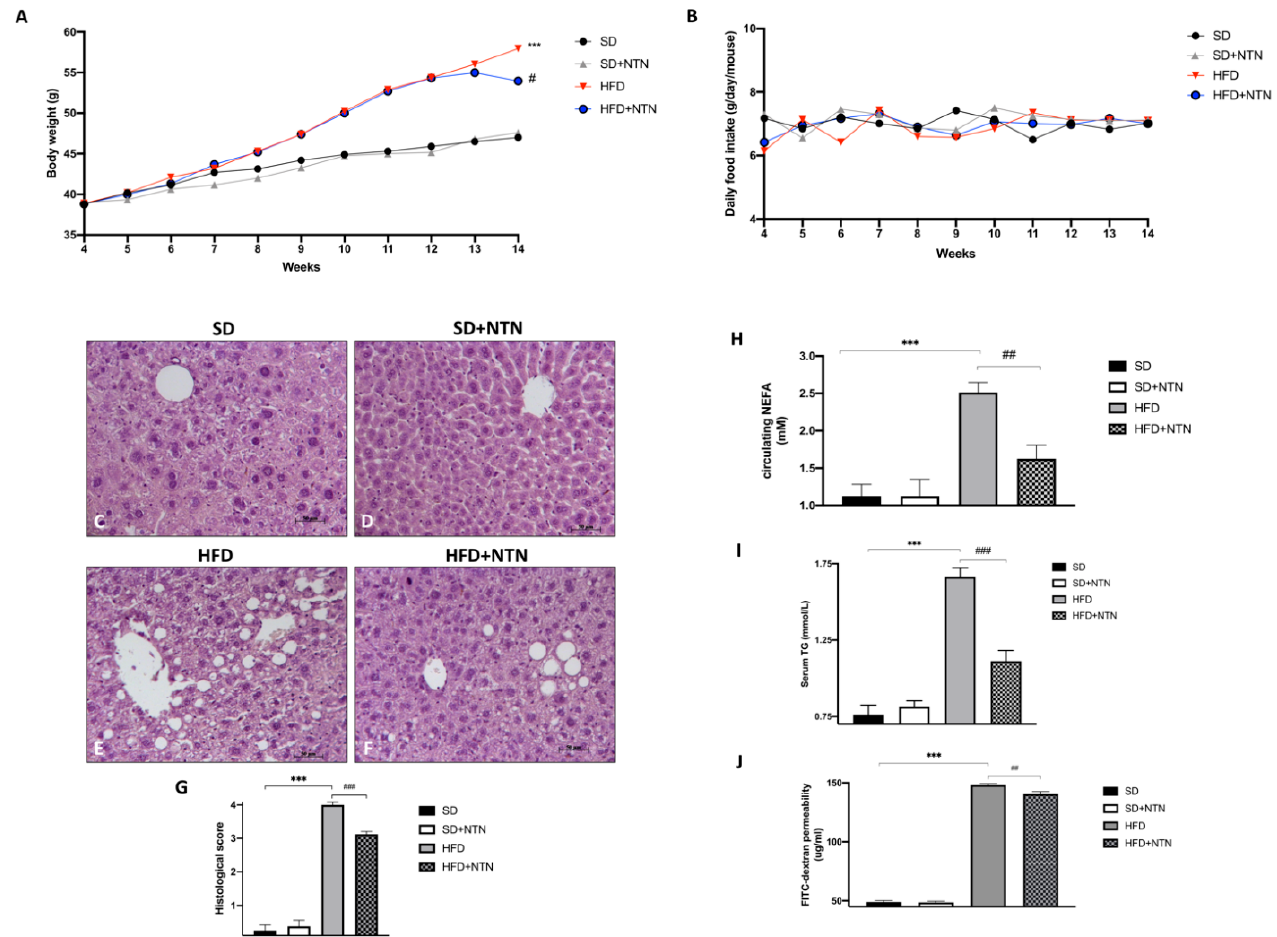
Figure 6. Effects of NTN on liver tissue, fat mobilization and gut permeability in HFD mice. HFD-fed mice showed a significant increase in body weight compared to the sham group ( A ); NTN considerably decreased weight gain ( A ). No significant differences were detected in mice food intake ( B ). Significant hydropic degeneration and steatosis were observed in mice fed with HFD ( E , G ) compared to SD and SD + NTN animals ( C , D , G ). Administration of NTN was able to significantly counteract the extent of liver damage ( F , G ). In addition, NTN administered mice decrease NEFA and TG levels compared to HFD mice ( H , I ). FITC-dextran permeability of jejunum was very low in SD mice ( J ). Contrarily, after HFD, mice displayed an increased intestinal permeability that was reduced by NTN administration ( J ). Data are representative of at least three independent experiments. Values are means ± SEM. One-Way ANOVA test. *** p < 0.001 vs. SD; # p < 0.05 vs. HFD; ## p < 0.01 vs. HFD; ### p < 0.001 vs. HFD.